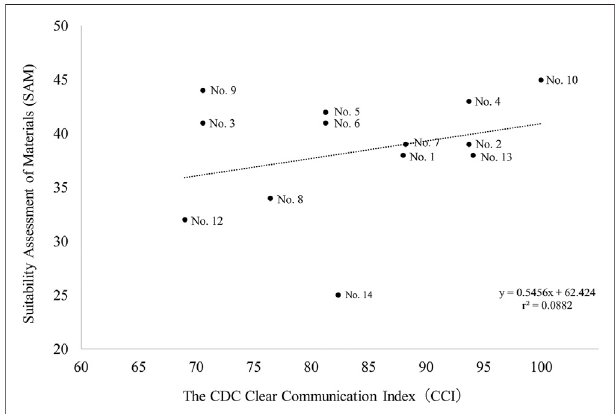
FIGURE 2 | Correlation of SAM and CCI total